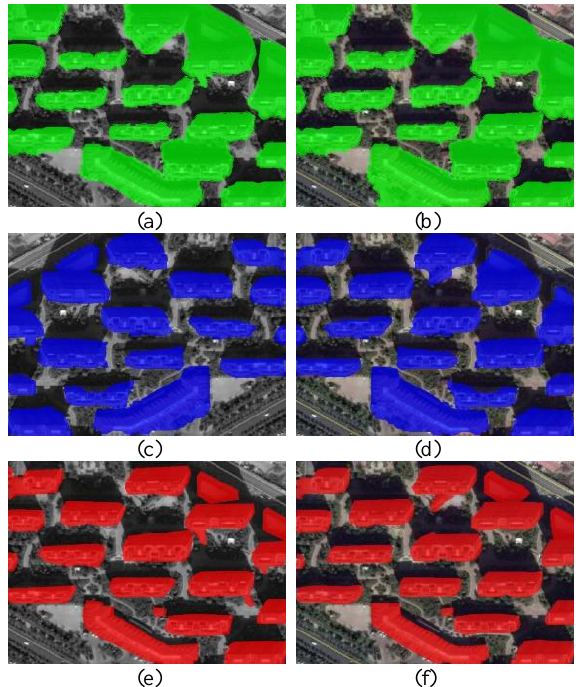
Figure 5. The Comparison of Building Extraction in The Same Urban Building Areas at Multispectral and Panchromatic Bands Figure 5(a) and Figure 5(b) are building extraction results using a gray-level threshold-based extraction method from multi- spectral band image and full-color image. Figure 5(c) and Figure 5(d) are results of extracting a building using an extraction method based on pixel classification from multi- spectral band image and full-color image. Figure 5(e) and Figure 5(f) are the results of building extraction using the method proposed in this paper from multi-spectral band image and full-color image. After comparison, the proposed method